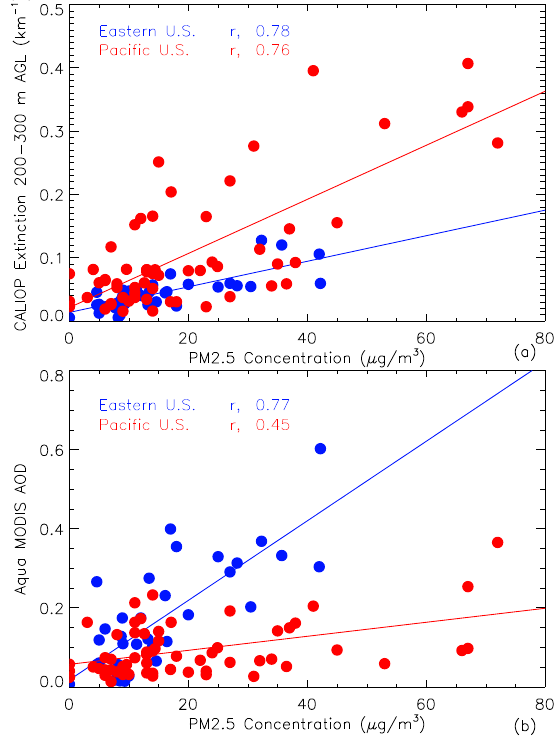
Figure 10. For the eastern (in blue) and Pacific (in red) US time zones, 2-year (2008–2009) scatterplots of hourly PM 2 . 5 concentra- tions versus (a) cloud-free 5km CALIOP dry mass 0.532µm extinc- tion at the 200–300m a.g.l. layer, and (b) operational Aqua MODIS AOD, both averaged within 40km and the hour of each respective PM 2 . 5